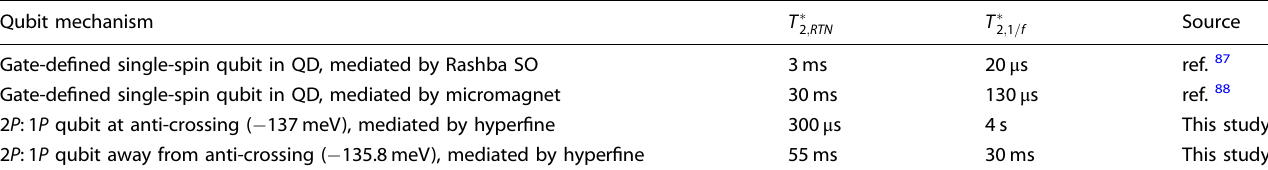
Table 2. Comparison of dephasing time due to random telegraph noise T (cid:3) anti-crossing, and 2P:1P qubit operated away from the anti-crossing. Qubit mechanism